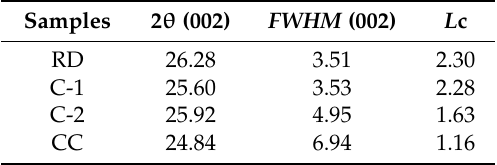
Table 3. Average stacking height L c of samples according to XRD spectra.